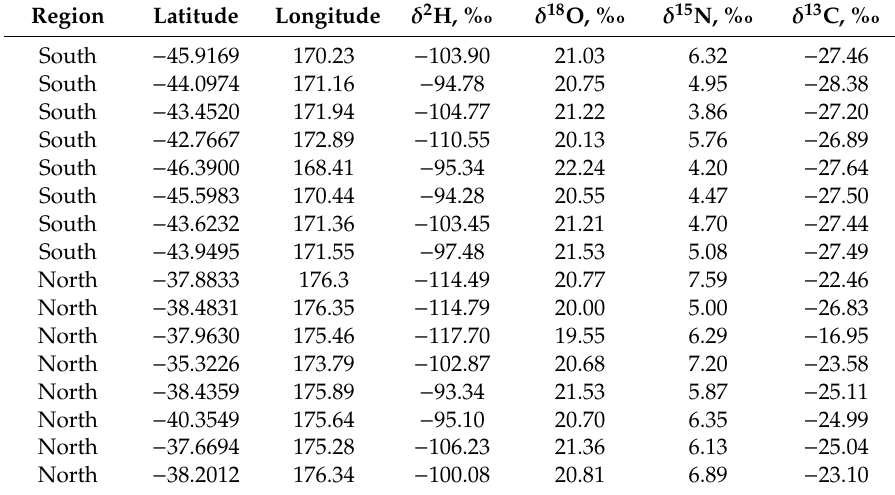
Table 1. Geographical coordinates of the farming locations and the isotopic values of the casein samples ( δ 2 H, δ 18 O, δ 15 N and δ 13